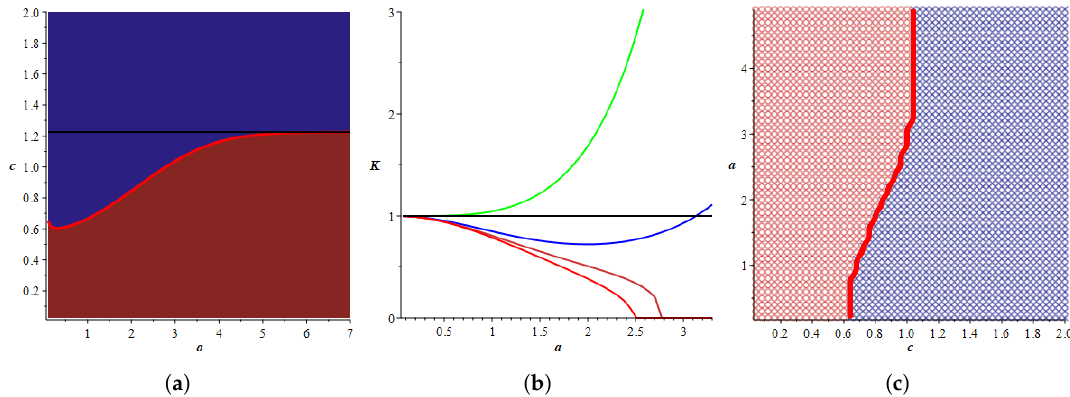
Figure 2. The figure depicts how the effect of the external signal turns upside down depending on the speed at which the signal-making wave propagates, c , and the amplitude of this wave, a . For all frames in this figure, p e = β = 2/3, ν 1 = ν 2 = 1, and a = A . The frame ( a ) illustrates the partition of c , a -plane ( 0 ) ( 0 ) arises from the inequality K ( (cid:101) f ,2/3,2/3,1,1 ) > κ ∗ ( 1,1 ) , where (cid:101) f = a sin ( ξ − c τ ) , κ ∗ ( 1,1 ) = 27/2 ( 0 ) ( p e , β ,1,1 ) attained at p e = β = 2/3. The area where this inequality is is the minimum value of κ c true (false) is in burgundy red (navy blue ) color. The curve colored in red indicates the interface of √ these areas and the black one corresponds to c = c ∗ ( 2/3,2/3,1,1 ) = 3/2. The frame ( c ) shows ( 0 ) the partition of c , a -plane by the inequality K ∗ ( (cid:101) f ,1,1 ) > κ ∗ ( 1,1 ) . The area where this inequality holds (fails) is filled with the orange circles (navy blue diagonal crosses). The red curve indicates the ( 0 ) interface of these areas. The frame ( b ) shows the values of max ( K ∗ ( f j ,2/3,2/3,1,1 ) / κ ∗ ( 1,1 ) ,0 ) vs. √ a , where f j = a sin ( ξ − c j τ ) , j = 1,2,3,4, c 1 = 3/5, c 2 = 1, c 3 = 1.1 3/2, c 4 = 3/2. The colors of the corresponding curves are green, blue, orange and red. The black curve corresponds to f = 0. Note that √ c ∗ ( 2/3,2/3,1,1 ) = 3/2 and min β c ∗ ( β , p e ,1,1 ) =